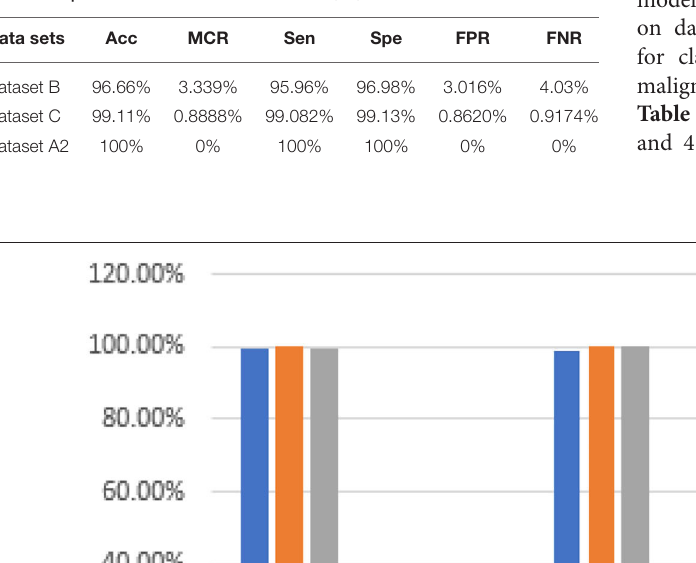
TABLE 15 | Statistical measures of datasets B, C, and A2.